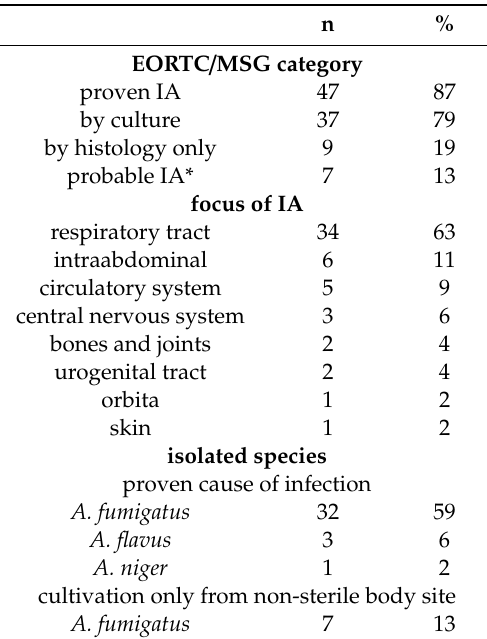
Table 2. Characteristics of infection